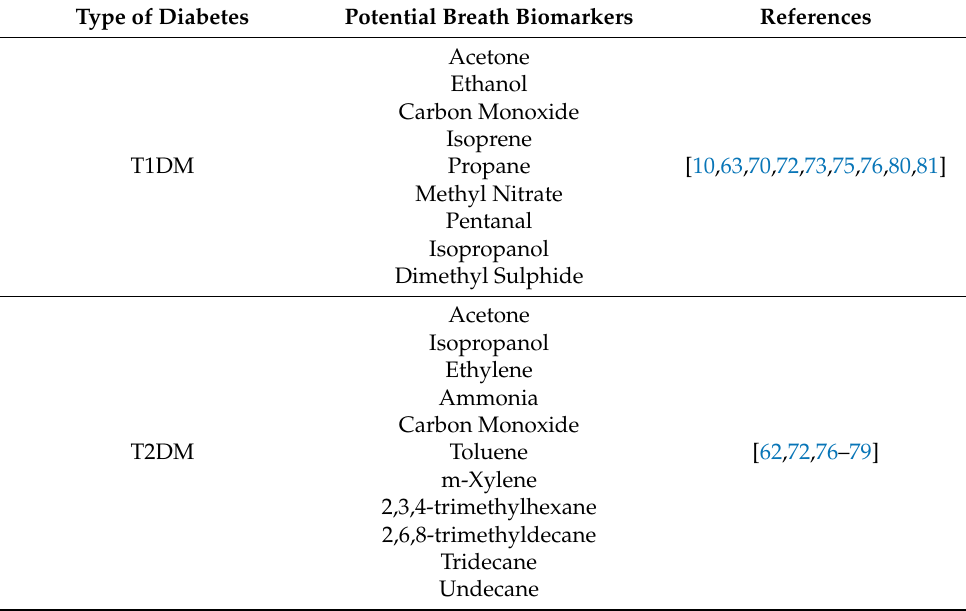
Table 3. Potential Standalone Exhaled Breath Biomarkers of Diabetes.